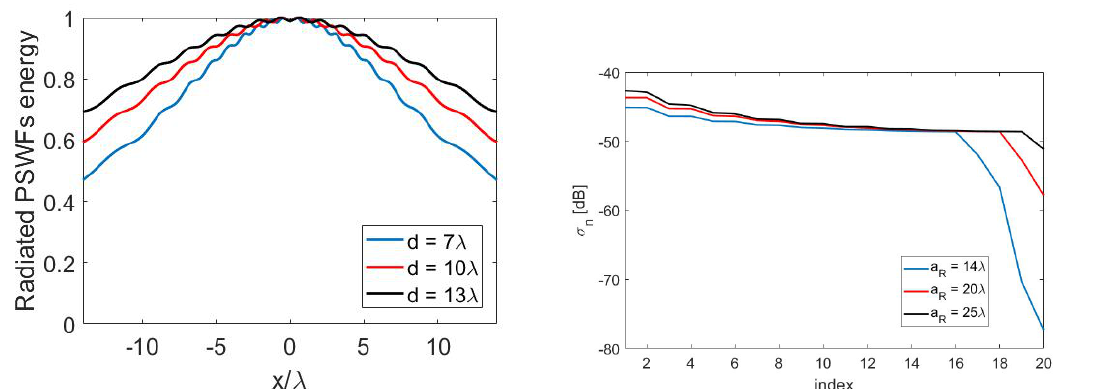
Figure 8. ( Left ): illustrating the spreading of the energy of the PSWFs for the case a T = 5 λ and a R = 7 λ and for an increasing distance d . ( Right ): increasing the size of a R to catch all the radiated DoFs for the case a T = 5 λ and d = 10 λ